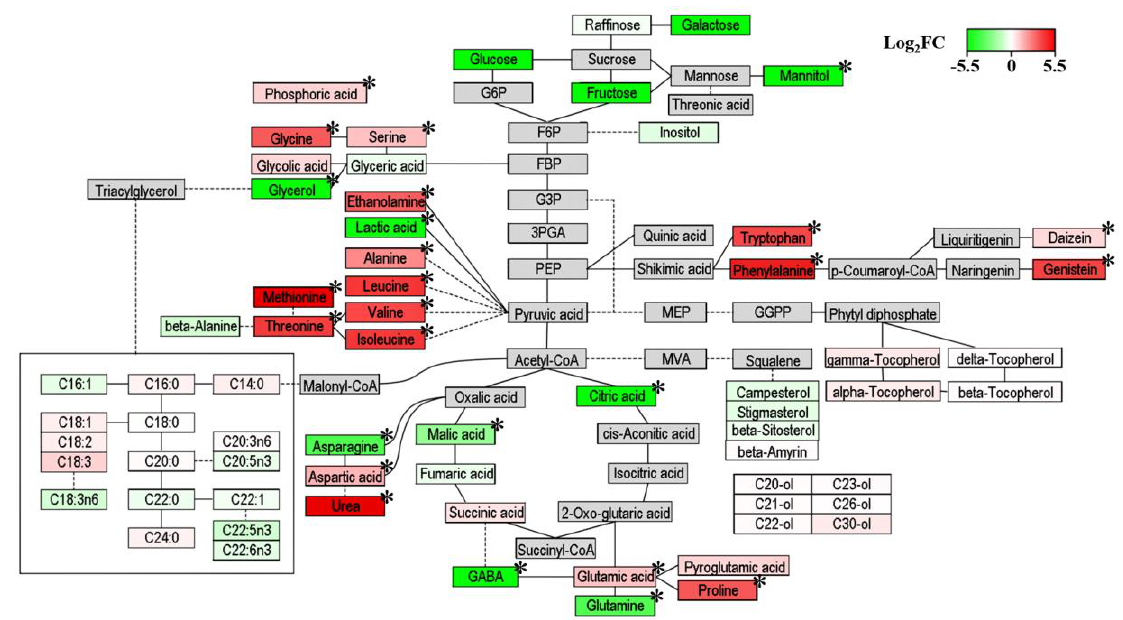
Figure 6. Metabolic pathway visualization and relative metabolite abundance for soybeans fermented by Aspergillus oryzae (AO) or Bacillus subtilis (BS) after water extraction at 55 °C. Fold changes from AO to BS were converted into log 2 FC (BS/AO) values ranging from −5.50 to 5.50. Positive log 2 FC values imply higher levels in BS-fermented soybeans and are shown in red, while negative log 2 FC values imply higher levels in AO-fermented soybeans and are shown in green. Extremely significant differences between AO and BS groups were identified by the t -test (* p < 0.0001).